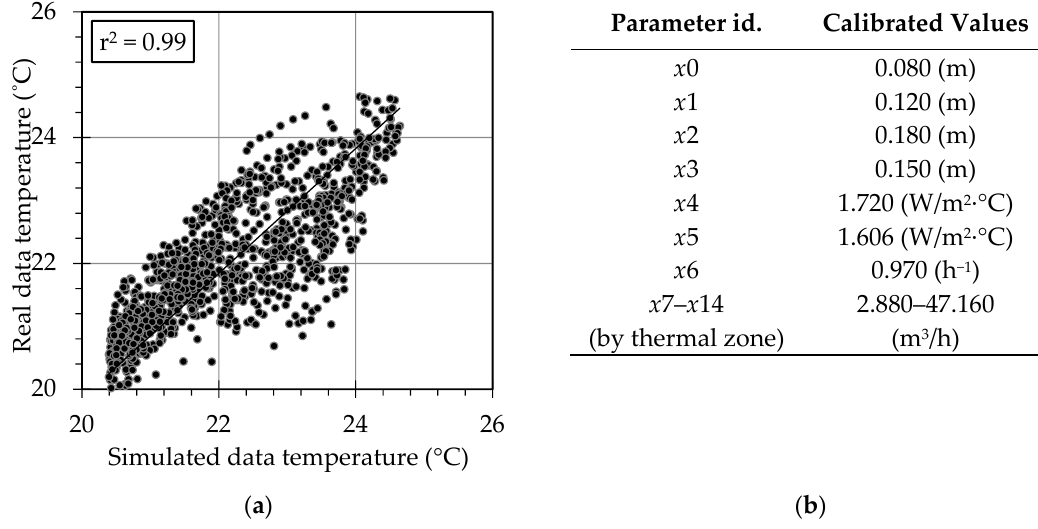
Figure 12 . Best model results for period under calibration—id. 10298: ( a ) index and correlation factor; ( b ) calibrated values.